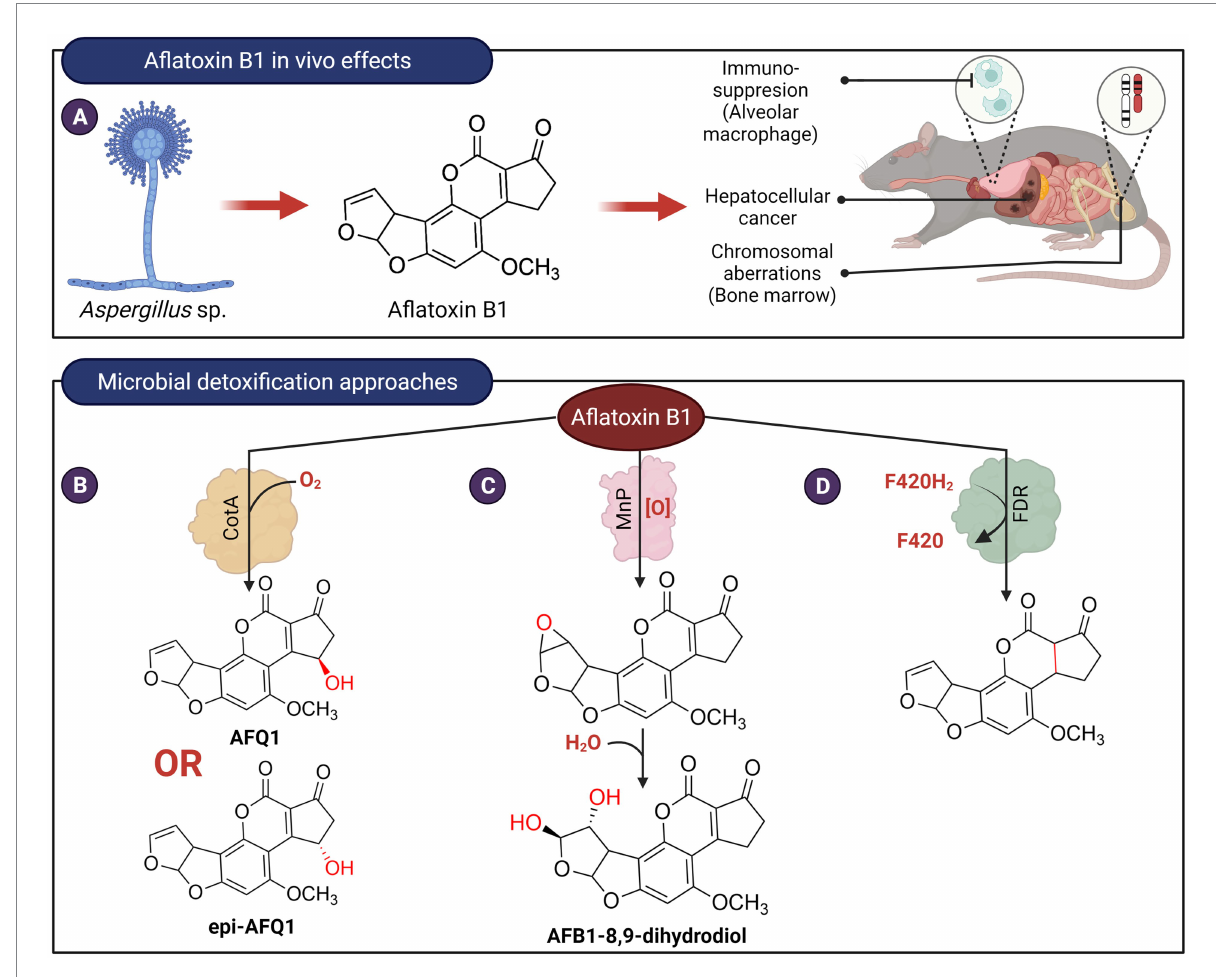
FIGURE 2 In vivo effects of aflatoxin B1 and microbial detoxification approaches. (A) Aflatoxin B1, produced by members of Aspergillus is carcinogenic, genotoxic, and possesses immunosuppressive properties. (B) Bacillus licheniformis ANSB821 utilizes the laccase, CotA to biotransform